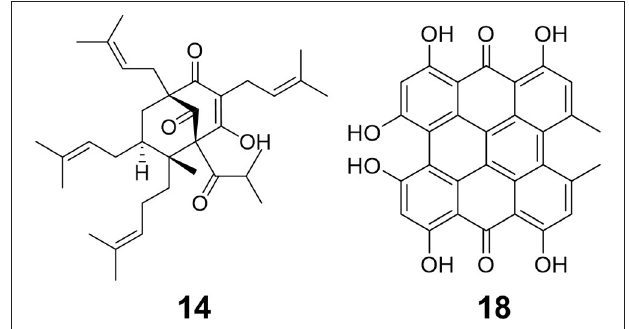
FIGURE 2 | Structures of two bioactive compounds, hyperforin (14) and hypericin (18) , examined in our chemical analysis of the H. perforatum extracts and traditional